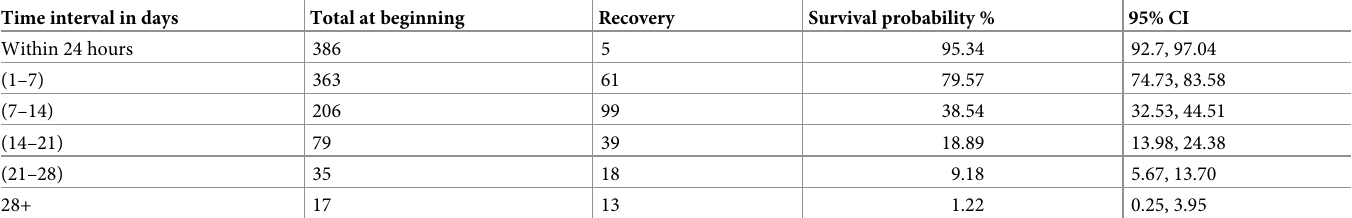
Table 2. Recovery probability of preterm neonates with RDS admitted in NICU at University of Gondar comprehensive specialized hospital from January 2016 to December 2018 (n = 386). Time interval in days Total at beginning